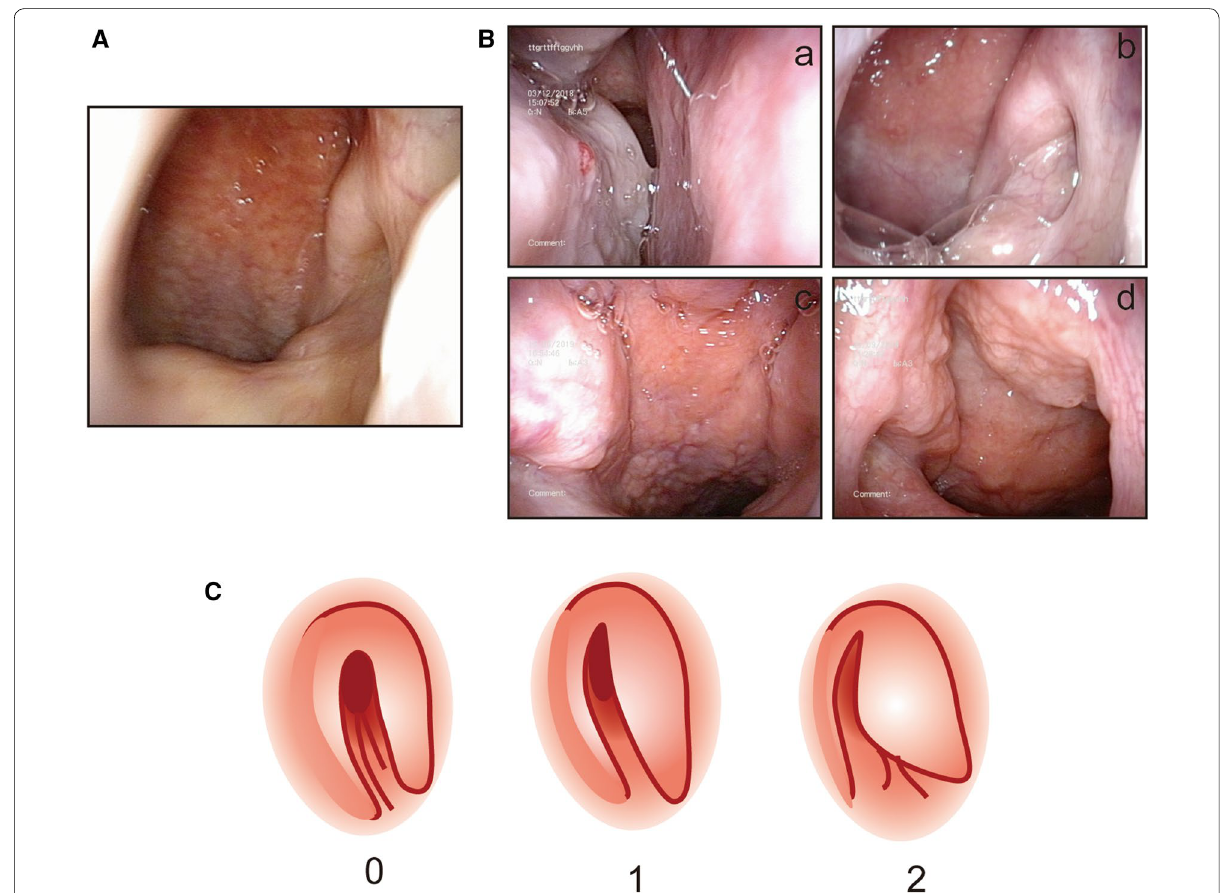
Fig. 1 Representative images for nasal endoscopic scores. A Representative image of posterior nostril area in control subject. B Representative images of posterior turbinate swelling (a), posterior nostril secretion (b), torus tubarius swelling (c), and nasopharyngeal lymphatic hyperplasia (d). C Schematic diagram of the shapes of pharyngeal orifices and its nasal endoscopic score (under 30° nasal